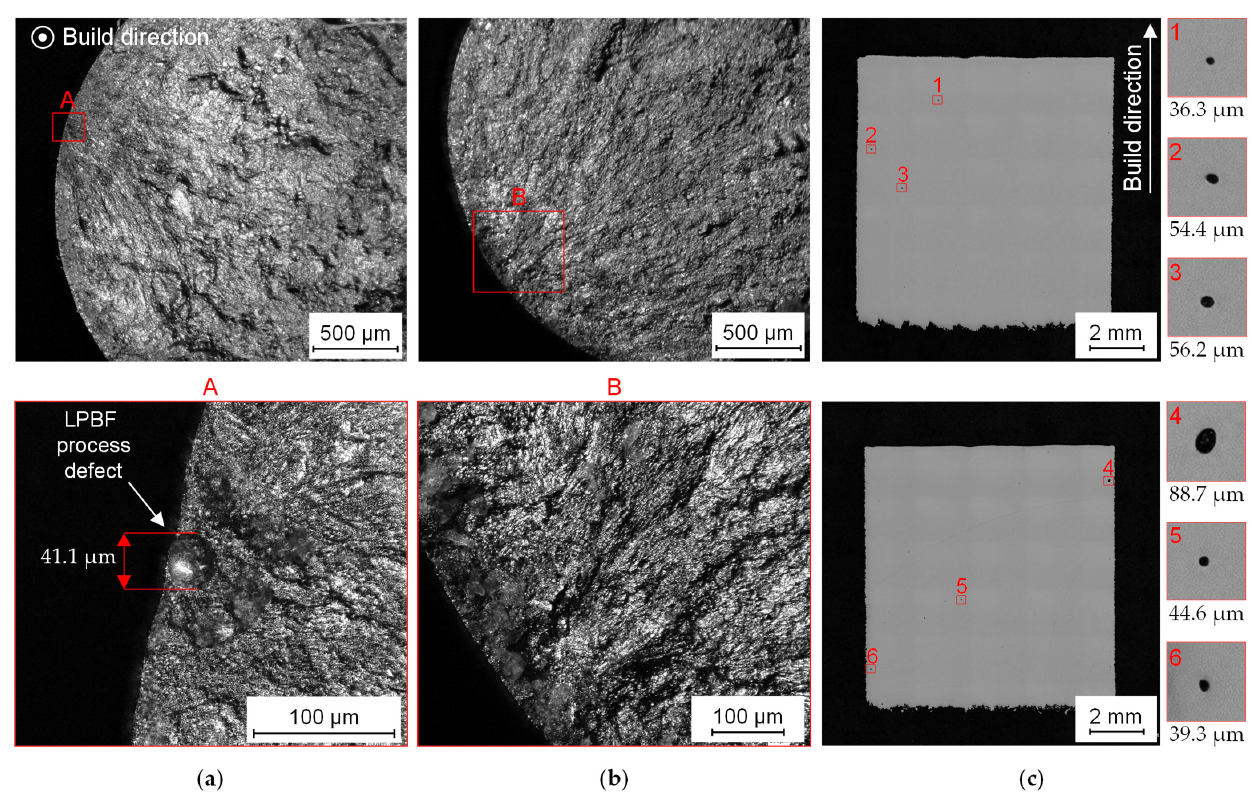
Figure 4. Fracture surface of two fatigue samples with crack initiation ( a ) at a gas pore as an LPBF process defect with detail view in A and ( b ) at solid material with detail view in B; Microscopical image of cross section of 10 mm × 10 mm × 10 mm cubic samples for optical density evaluation with indicated dimensions of six characteristic pores (1–6) in detail views ( c ).